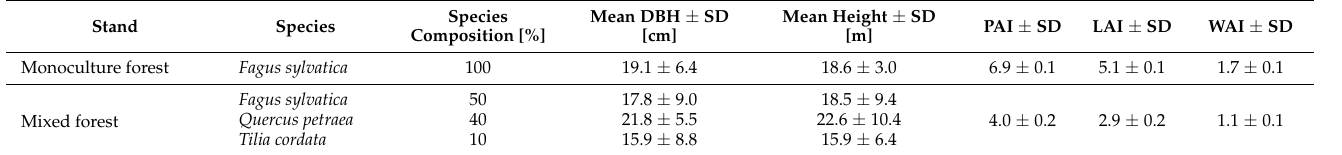
Table 1. Characteristics of